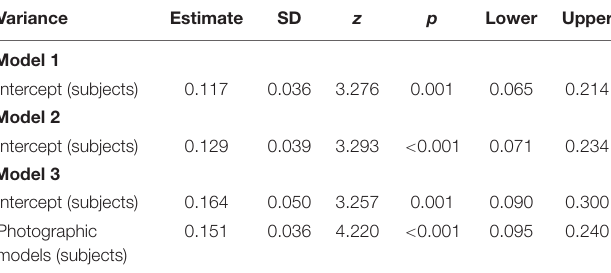
TABLE 3 | Random effects in logistic regression